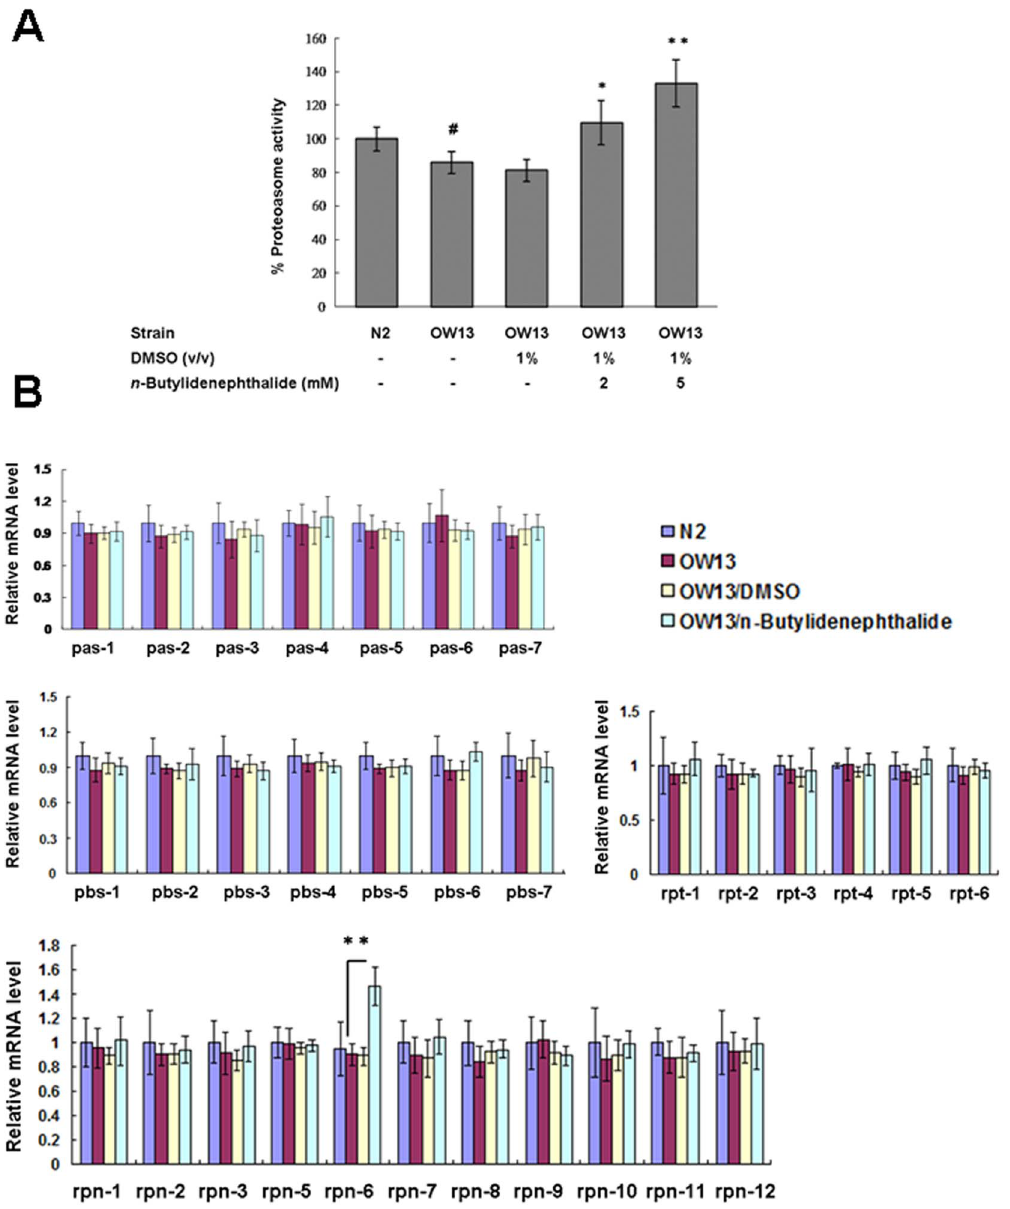
Figure 10. n -Butylidenephthalide augments proteasome activity by enhancing the expression of rpn-6 in the OW13 strain of C. elegans . (A) n -Butylidenephthalide augments proteasome activity in the OW13 strain of C. elegans . Chymotrypsin-like activity of the proteasome was monitored by Z-Gly-Gly-Leu-AMC digestion in a day 3 adult animal extract containing equal amounts of total protein. The data represent the mean 6 SD (n=3). A hash ( # ) indicates significant differences between N2 and OW13 animals ( p , 0.05); an asterisk (*) indicates significant differences between the OW13 control samples and the n -butylidenephthalide-treated OW13 samples (* p , 0.05, ** p , 0.01). (B) n -Butylidenephthalide enhances the expression of rpn-6 of proteasome in the OW13 strain of C. elegans . Quantitative real-time RT-PCR experiments show the expression level of individual subunit of the 26S proteasome, using RNAs isolated from OW13 control or n -butylidenephthalide-treated animals. The data represent the mean 6 SD (n=3). An asterisk (*) indicates significant differences between the OW13 control samples and the n -butylidenephthalide-treated samples (** p , 0.01).